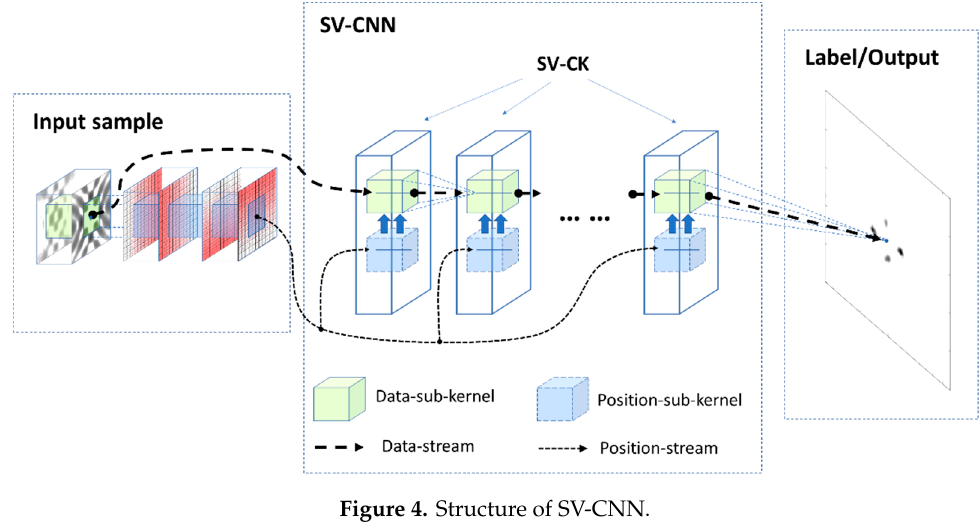
Figure 4. Structure of SV-CNN.